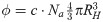
Viscosity of the folded and unfolded protein.A) Bulk viscosity variations with increasing concentration of BSA (square markers): in a pure buffer (blue markers), and a buffer with 7 M of urea (red markers). These measurements are repeated for 50 μL volume in the meniscus configuration (circles markers). The experiments were carried out at T = 25°C and T = 26°C in the meniscus and the conventional configurations, respectively. B) The full data set for several urea concentrations are fitted to Eq 7 using the hydrodynamic radius as adjustable parameter. C) A full set of solution viscosities is obtained from direct measurements of ωr (Eq 6) through a Gaussian fit to the maximum PSD. Symbols represent the experimental data and lines represent the corresponding fit. The color scale, at the right hand side of panel C, represents the urea concentration in panels B and C. Note that ϕ=c·Na43πRH3, with c in mM.